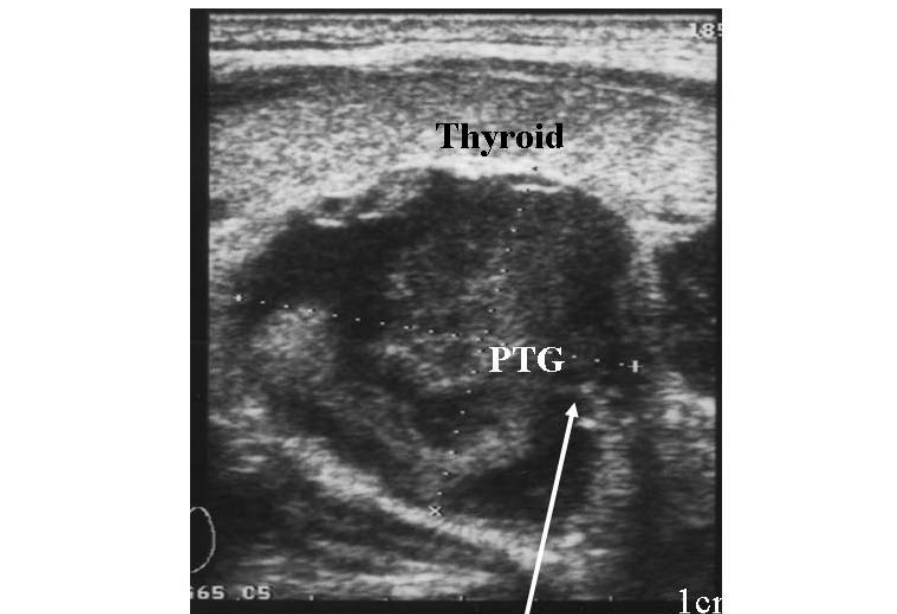
FIGURE 4 . PTG with nodular changes in 43-year-old woman, on dialysis treatment 11 years, PTH > 1500 pg/ml (longitudinal section, linear probe 13 MHz). Hyperechogenic echoes that correspond to nodular